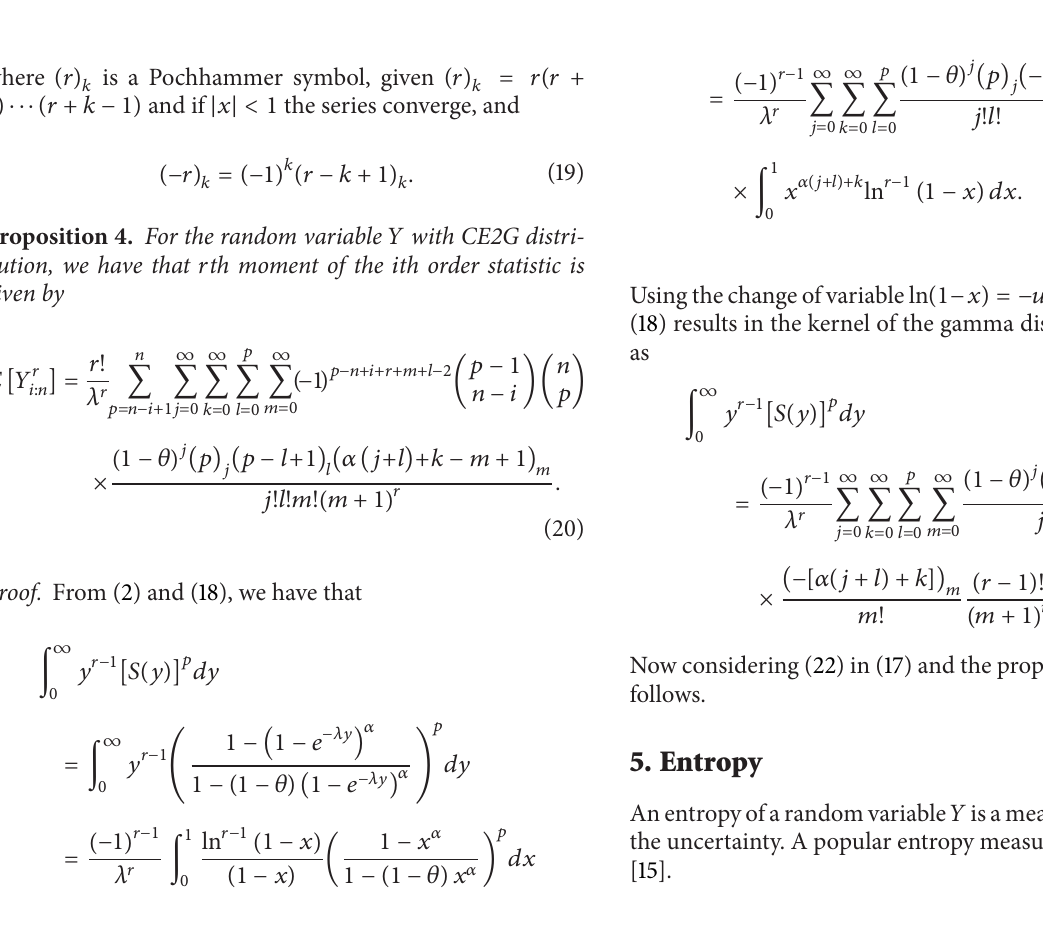
Figure 2: (a) Kurtosis and skewness of CE2G distribution for fixed 𝜆 = 1 . (b) Kurtosis and skewness of CE2G distribution for fixed 𝜆 = 2 .